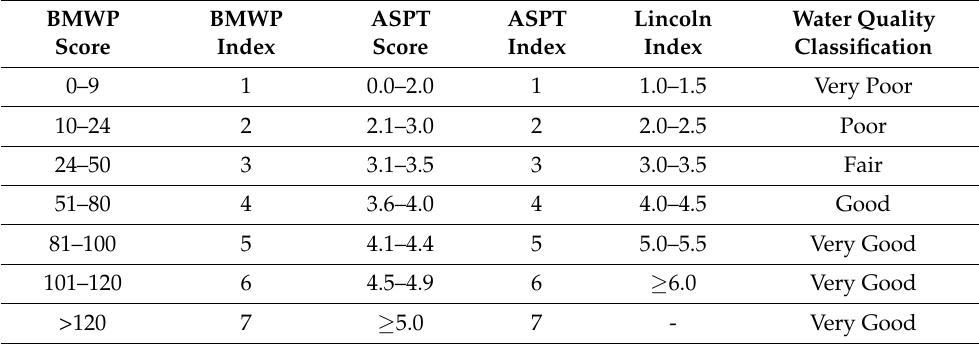
Table 1. Biotic-based water quality assessment criteria based on BMWP-Thai and its corresponding water quality classification